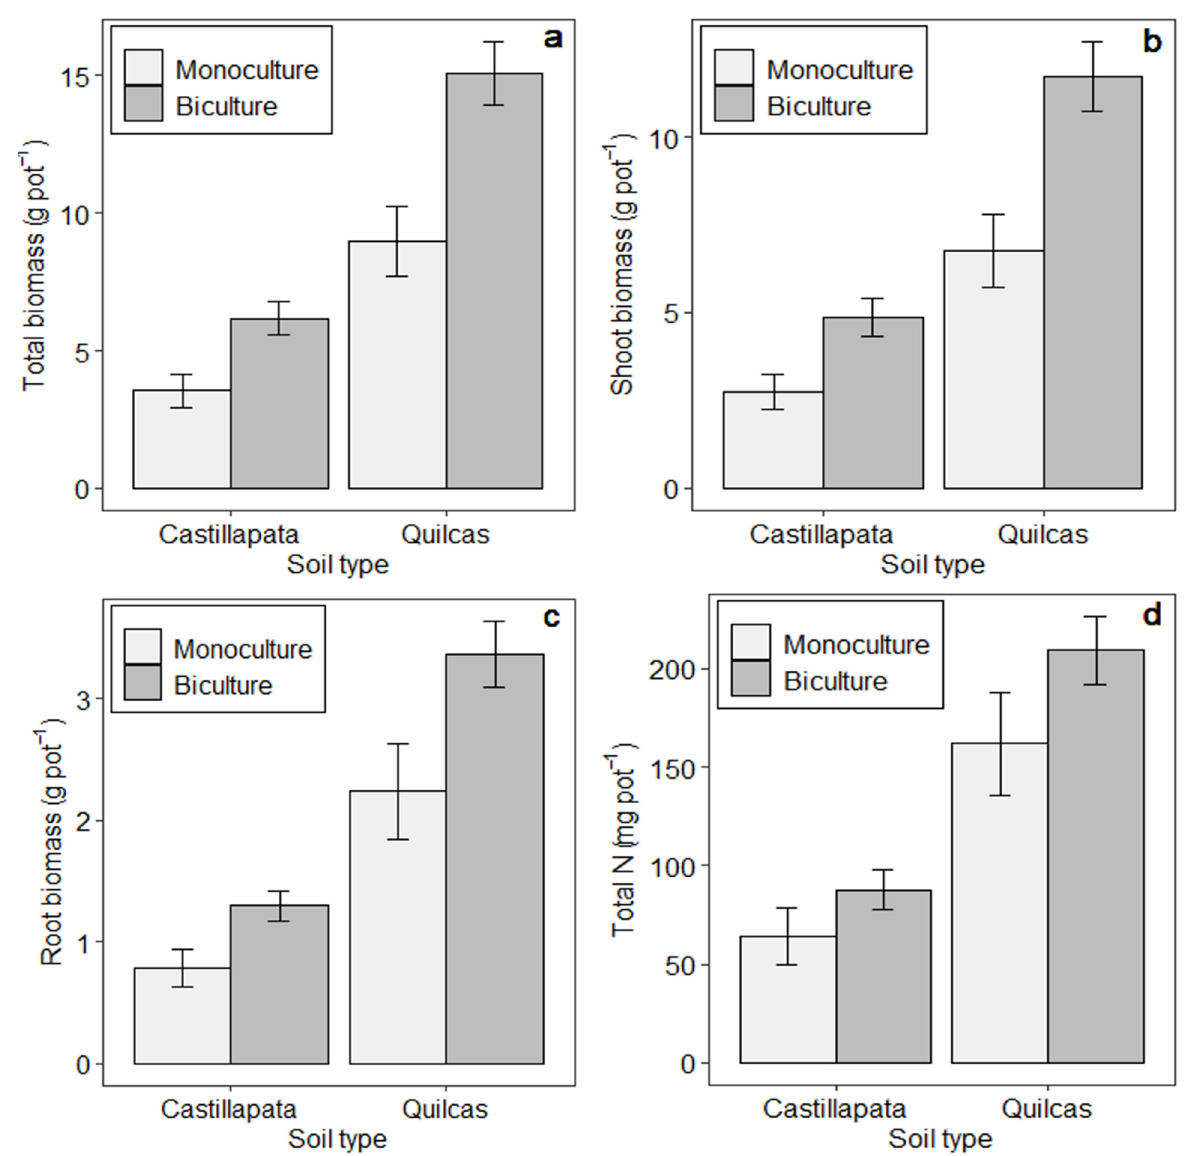
Figure 1. Mean performance metrics for all bicultures vs. monocultures (averaged across treatments) and presented separately for each soil type. Panels refer to: ( a ) Total biomass, ( b ) Shoot Biomass, ( c ) Root Biomass, and ( d ) Total N uptake. Means and the standard errors correspond to the original data (without transformation).